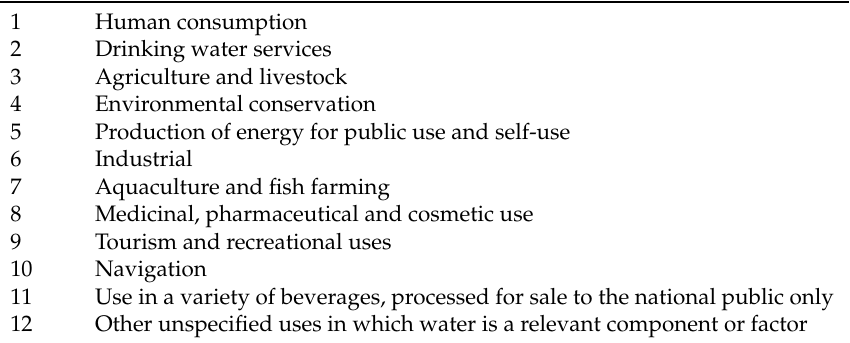
Table 1. Prioritization for granting water concessions in Law